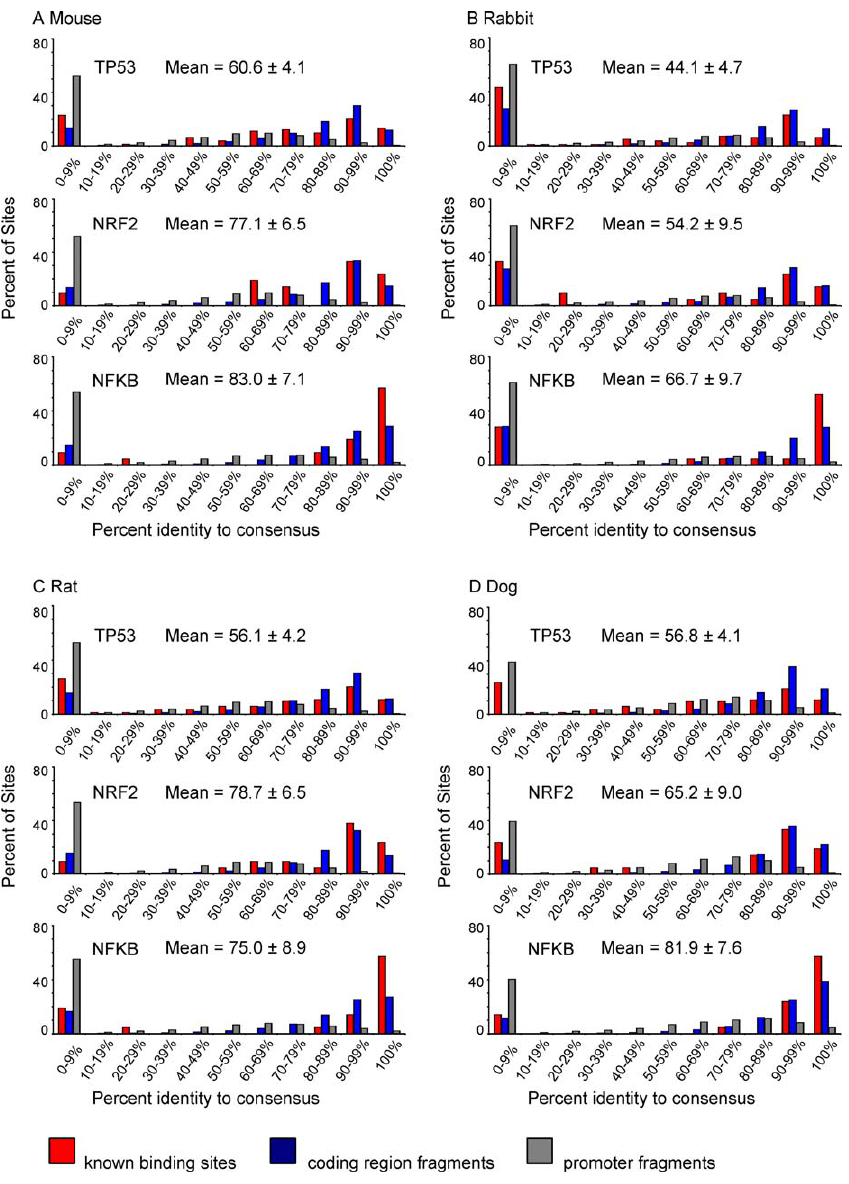
Figure 2. Distribution of Human-to-Mammal TFBS Conservation Scores Graphed for each (human-to-mouse, -rabbit, -rat, and -dog) comparison in (A–D) are: the percentage of all TFBSs from each gene group (p53, 83 REs; NRF2, 21 REs; or NF j B, 21 REs) that fall within the x-axis conservation bins (red bars); data for randomly sampled fragments from human coding regions (blue bars); and gene promoters (gray bars). Coding regions (representing sequence under purifying selection) and randomly sampled promoter regions (representing sequence under more neutral selection) were sampled 1,000 trials; error bars are narrower than the line art. Averages and standard errors for the sets of known TFBSs are reported above each graph.